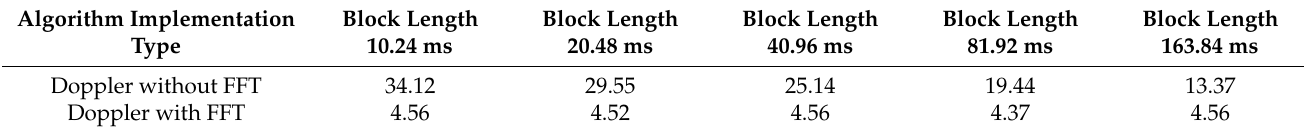
Table 2. GPU RTX 3060 Performance Boost vs. CPU Intel Core i7-8700.